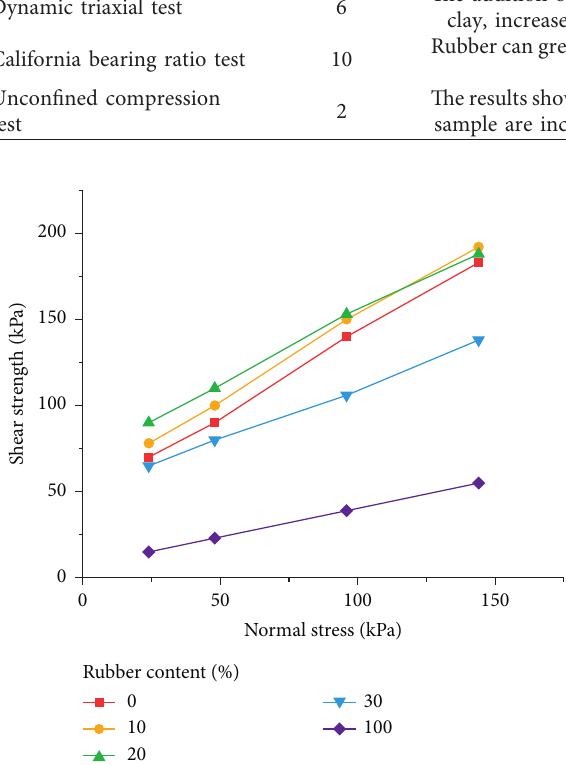
Figure 3: Shear strength of the mixture of tire strips and loess under different tire strip content (modified from